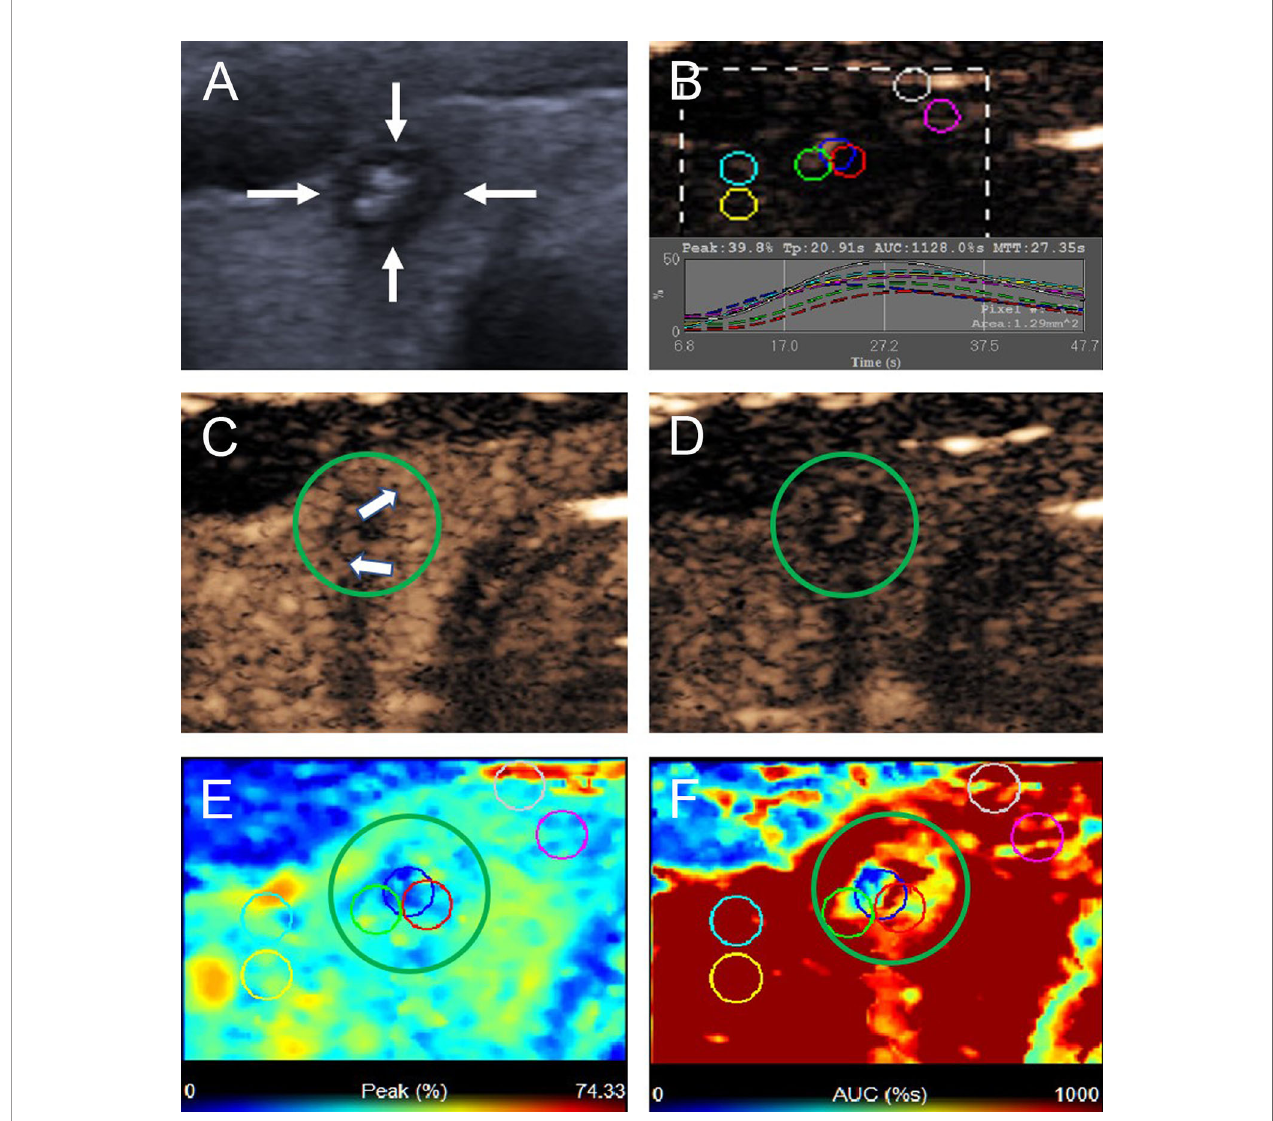
FIGURE 3 | A 22-year-old woman with the B pattern mummi fi ed thyroid nodule proven by FNAB. (A) Nodule showed solid component, hypoechogenicity, ill-de fi ned margin, taller than wide shape and microcalci fi cation (TI-RADS 5). (B) Time-intensity curve showed the CEUS parameters of this nodule compared with peripheral thyroid parenchyma. (C) The early phase of CEUS showed a heterogeneous hypo-enhancement (white arrows) in the whole nodule (green circle). (D) The late phase of CEUS showed the microbubbles in the nodule fade away with a clear margin compared with peripheral thyroid parenchyma. (E) Parametric color map showed the values of peak for the nodule was uneven deep blue and blue, compared with the surrounding yellow and blue color of thyroid parenchyma, indicated the peak intensity of the nodule was lower than peripheral thyroid parenchyma. (F) Parametric color map showed that the AUC for the nodule was uneven deep blue and yellow color, compared with the surrounding red color of thyroid parenchyma, indicated AUC of the nodule was lower than peripheral thyroid